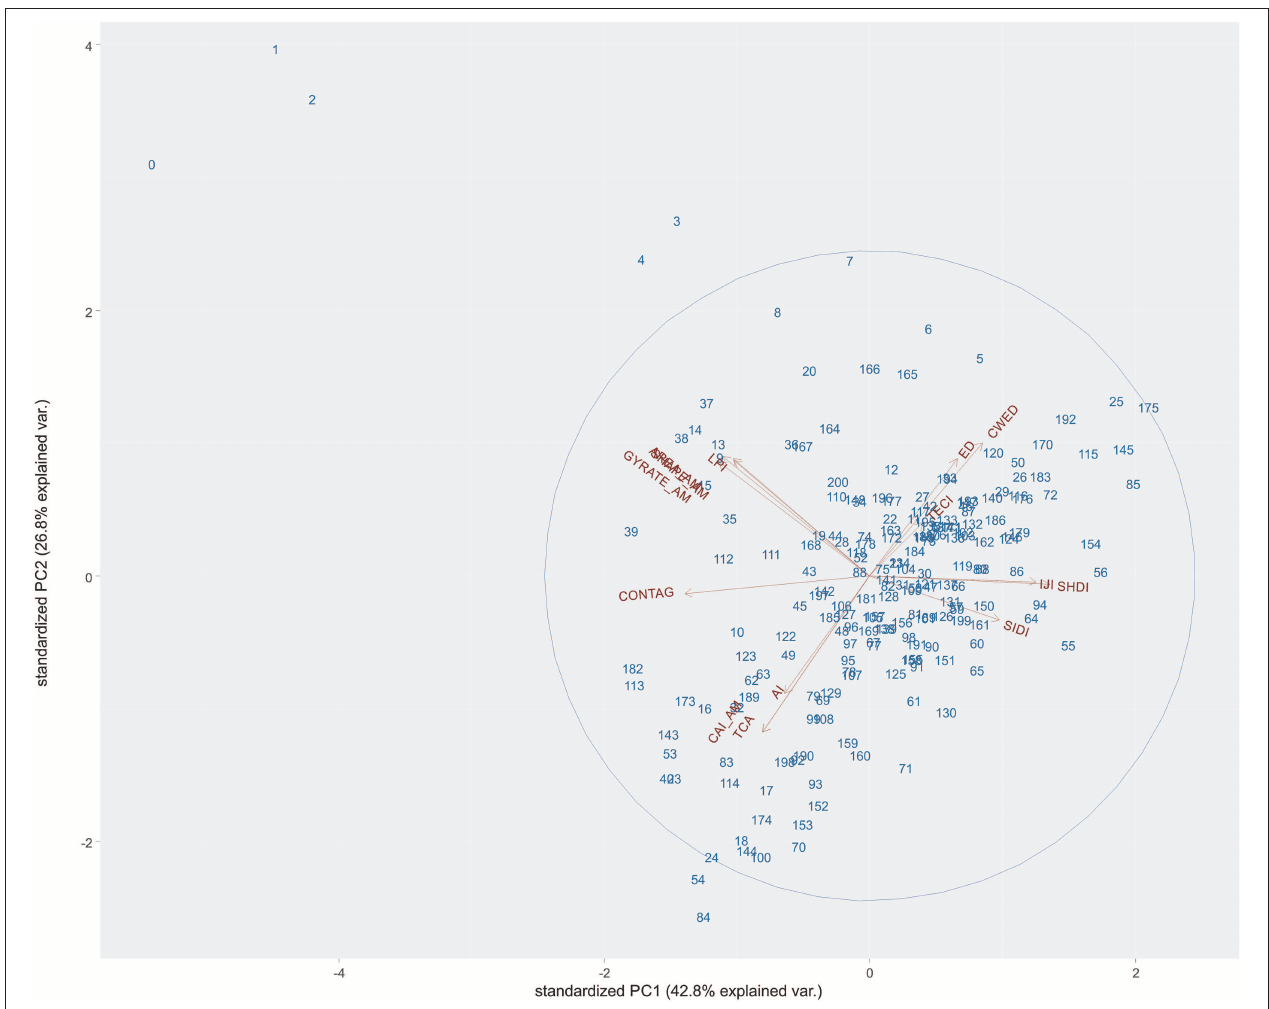
FIGURE 7 | Multi-temporal principal components plot of landscape-level metrics in the Prospect Creek watershed across the simulation time. Blue numbers represent landscape conditions at each time step, which represent years of simulation/10. The blue ellipse contains 95% of the simulated range in principal components space. The red vectors represent the direction of change in each of the landscape metrics, whose acronyms are shown at the end of each vector. AI, Aggregation Index; TCA, Total Core Area; CAI_AM, Area-weighted Core Area Index; CONTAG, Contagion; GYRATE_AM, Correlation Length; AREA_AM, Area-weighted Mean Patch Size; LPI, Largest Patch Index; ED, Edge Density; CWED, Contrast-weighted Edge Density; IJI, Interspersion and Juxtaposition Index; TECI, Total Edge Contrast Index; SHDI, Shannon’s Diversity Index; SIDI, Simpson’s Diversity Index.